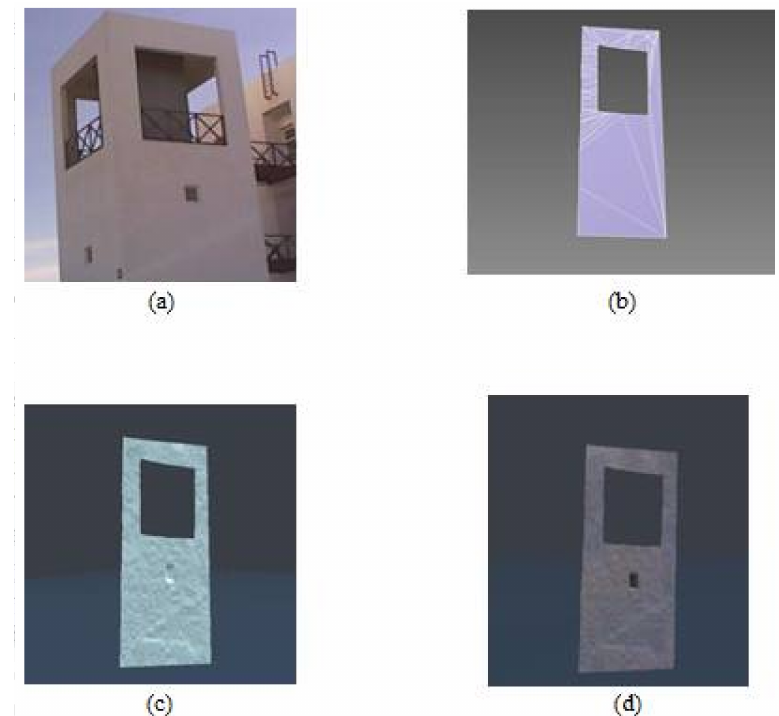
Figure 10. The final 3D model stages for the campus building: ( a ) initial building image; ( b ) after the addition of inner building protrusion information; ( c ) enriched model via normal mapping; and ( d ) the final 3D reconstruction after texture addition through image